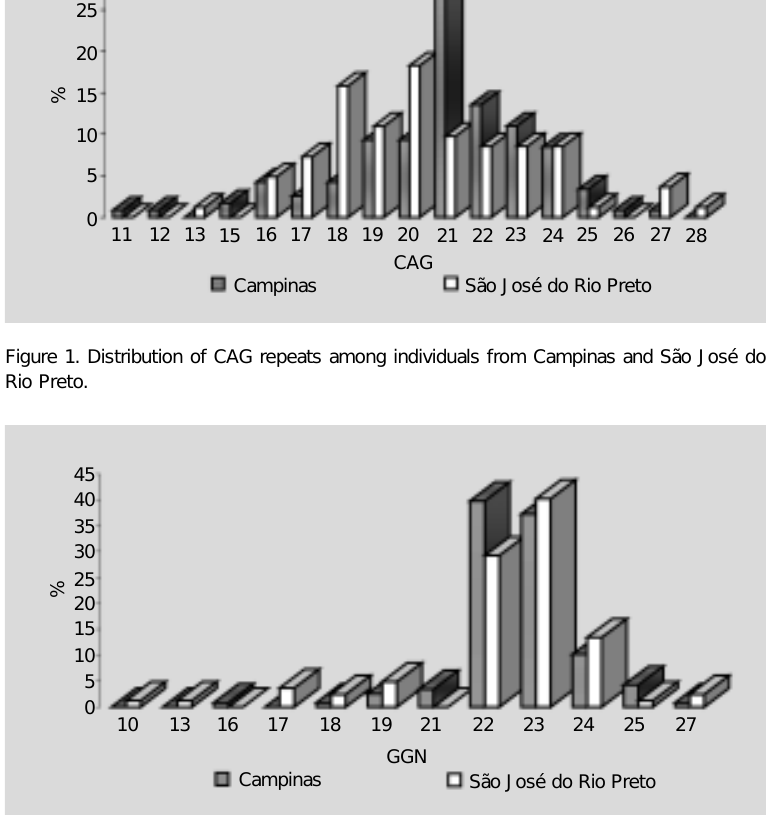
Figure 2. Distribution of GGN repeats among individuals from Campinas and São José do Rio